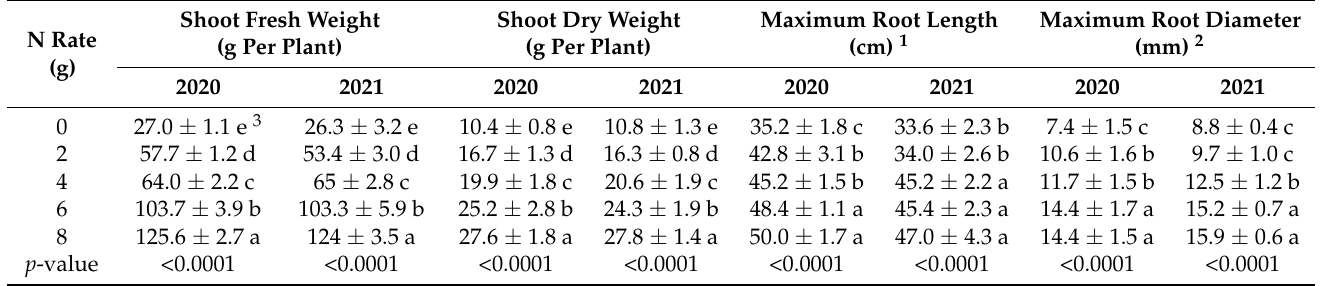
Table 2. Shoot fresh weight, dry weight, maximum root length, and maximum root diameter of plants receiving five N rates in 2020 and